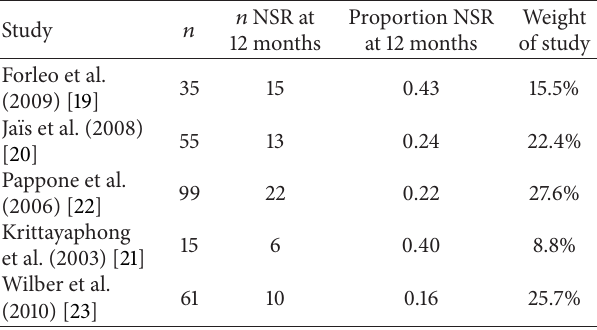
Table 1: Studies used to estimate probability of being in NSR at 1 year for